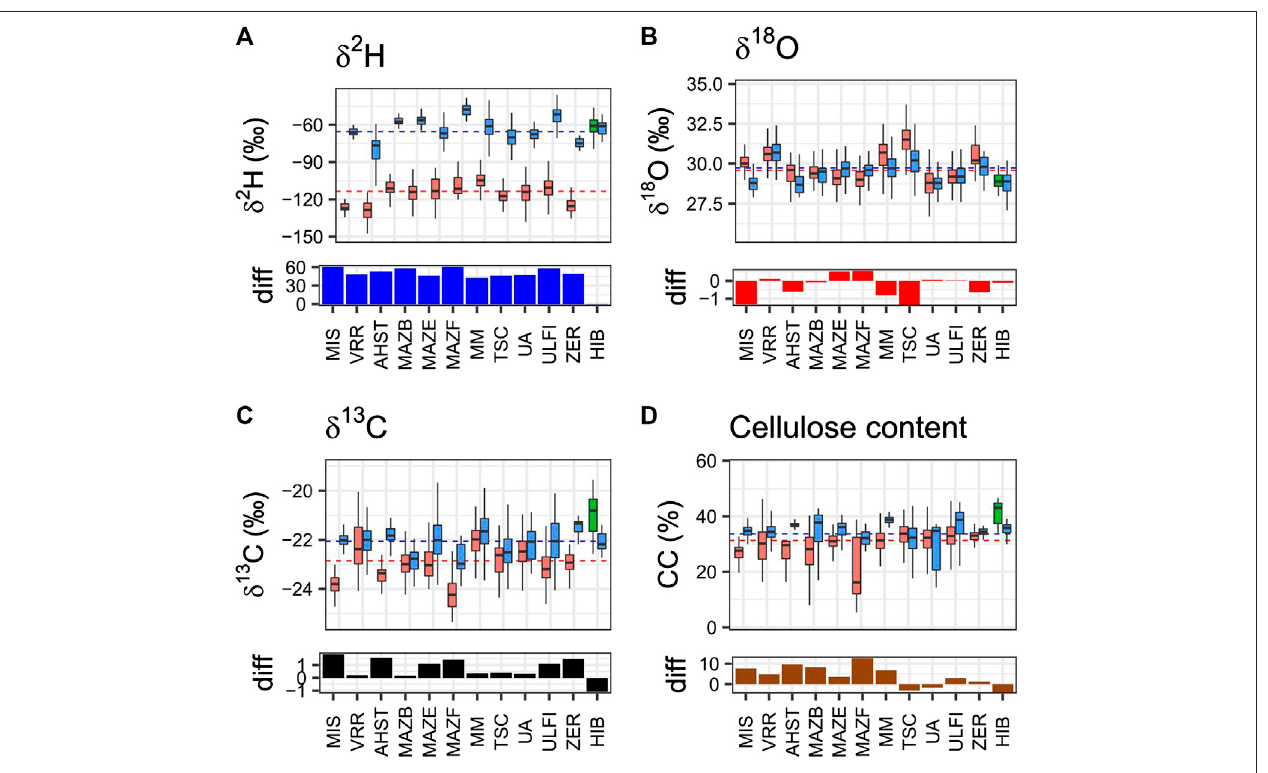
FIGURE 3 | Isotopes in the cellulose of sub-fossil Holocene trees. Tree samples were collected at 12 different sites in the Alps. Site abbreviations are indicated below the plots. Samples were dated by dendrochronological tools and the extracted cellulose analyzed for δ 2 H, δ 18 O and δ 13 C isotope ratio variations and for their cellulose content. Each box representsmedian and limits of25th and 75th percentile ofeach specie ineach site, and the species are depicted indifferent colors: larch in red, cembran pine in blue and the single spruce in green. The horizontal black dashed line are the total mean values of cembran pine and larch. The histograms under the box plots show the per mil difference (diff) between the means, larch minus cembran pine (larch minus spruce for the HIB site). AHST: LADE n samples: 49 n trees: 2 — PICE: n sample: 33 n trees: 1LADE: MAZB n sample: 185 n trees: 6 — PICE n sample: 54 n trees: one LADE: MAZE n sample: 180 n trees: 5 — PICE n